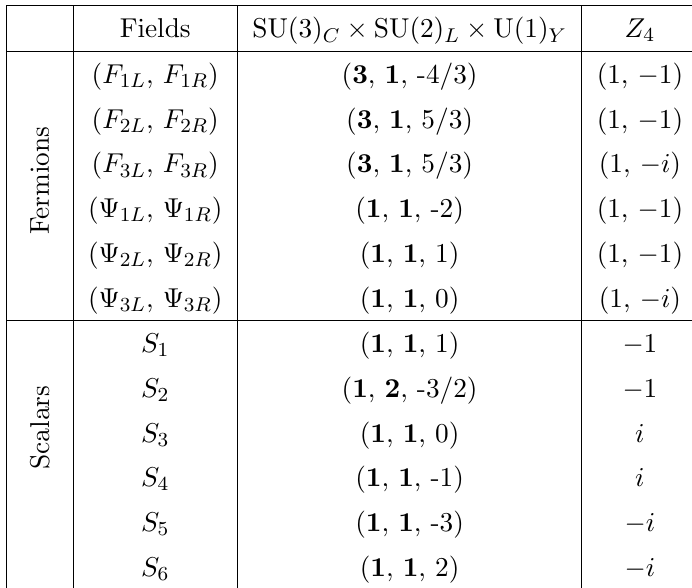
Table 5 . Charge assignments for the fermions and scalars contributing to the diagrams (cid:12)gures 1{4. In the brackets of the Z 4 -column we indicate the corresponding charges of the left-handed and right-handed vector-like fermions, respectively. Here S i